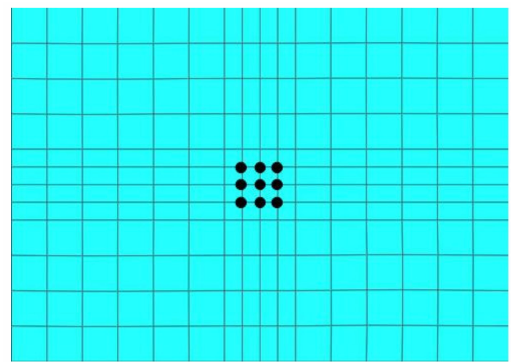
Figure 4. Boundary conditions of freely expanding plate.